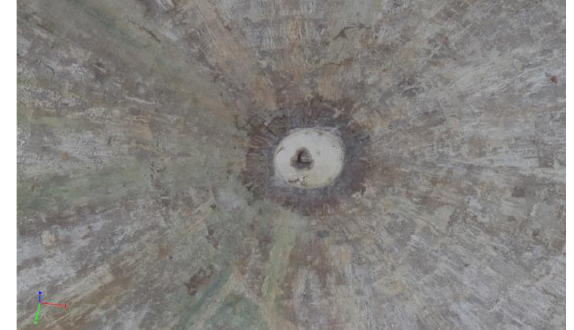
Figure 12: 3D reconstruction result for the lower section of the stairs. Consistency occurs in the shape and edges of the stairs.